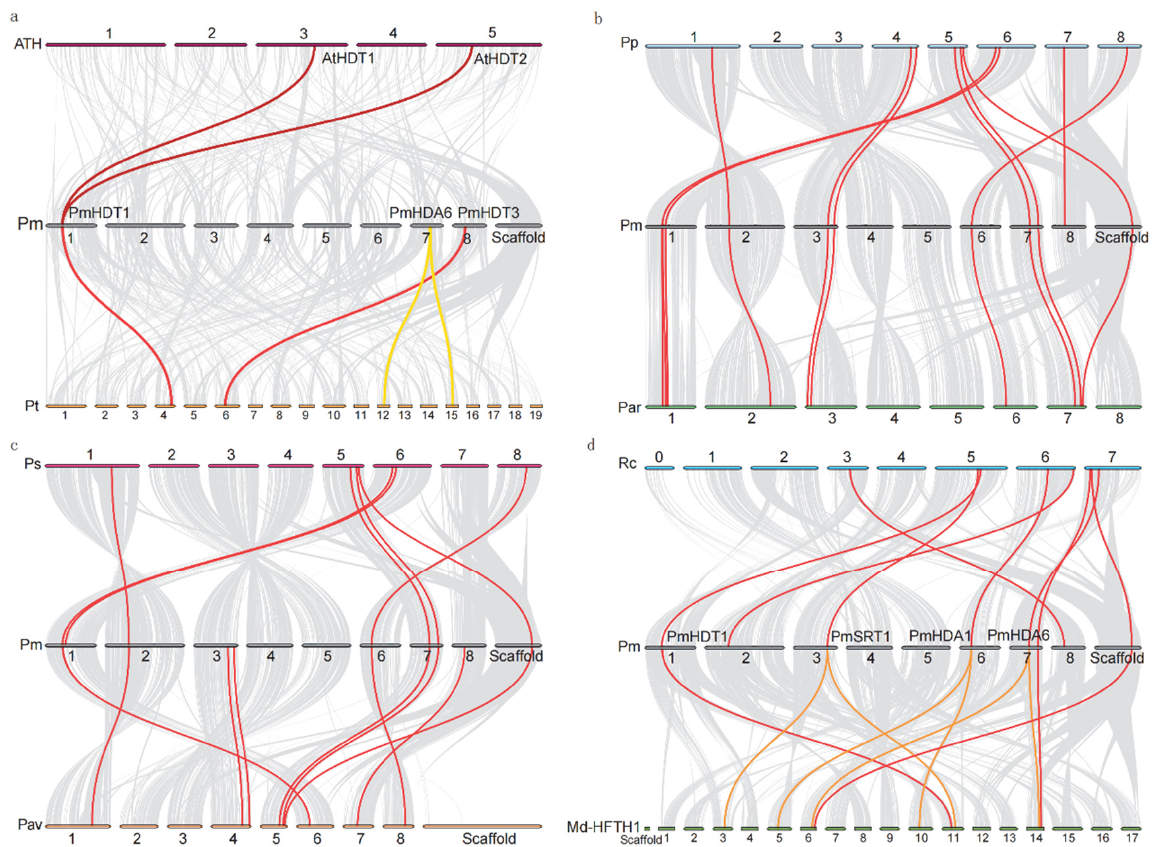
Figure 6. Macrosynteny pattern between the P. mume and other plants karyotype of HDACs. Grey lines highlight the syntenic blocks spanning the genome. Red, yellow, and orange lines highlight the major segmental duplications of HDACs inter-chromosomes. ( a ) A. thaliana (ATH) vs. P. mume (Pm) vs. P. trichocarpa ( b ) P. persica (Pp) vs. P. mume (Pm) vs. P. armeniaca ( c ) P. salicina (Ps) vs. P. mume (Pm) vs. P. avium (Pav) ( d ) R. chinensis (Rc) vs. P. mume (Pm) vs. M. domestica (Md-HFTH1) .